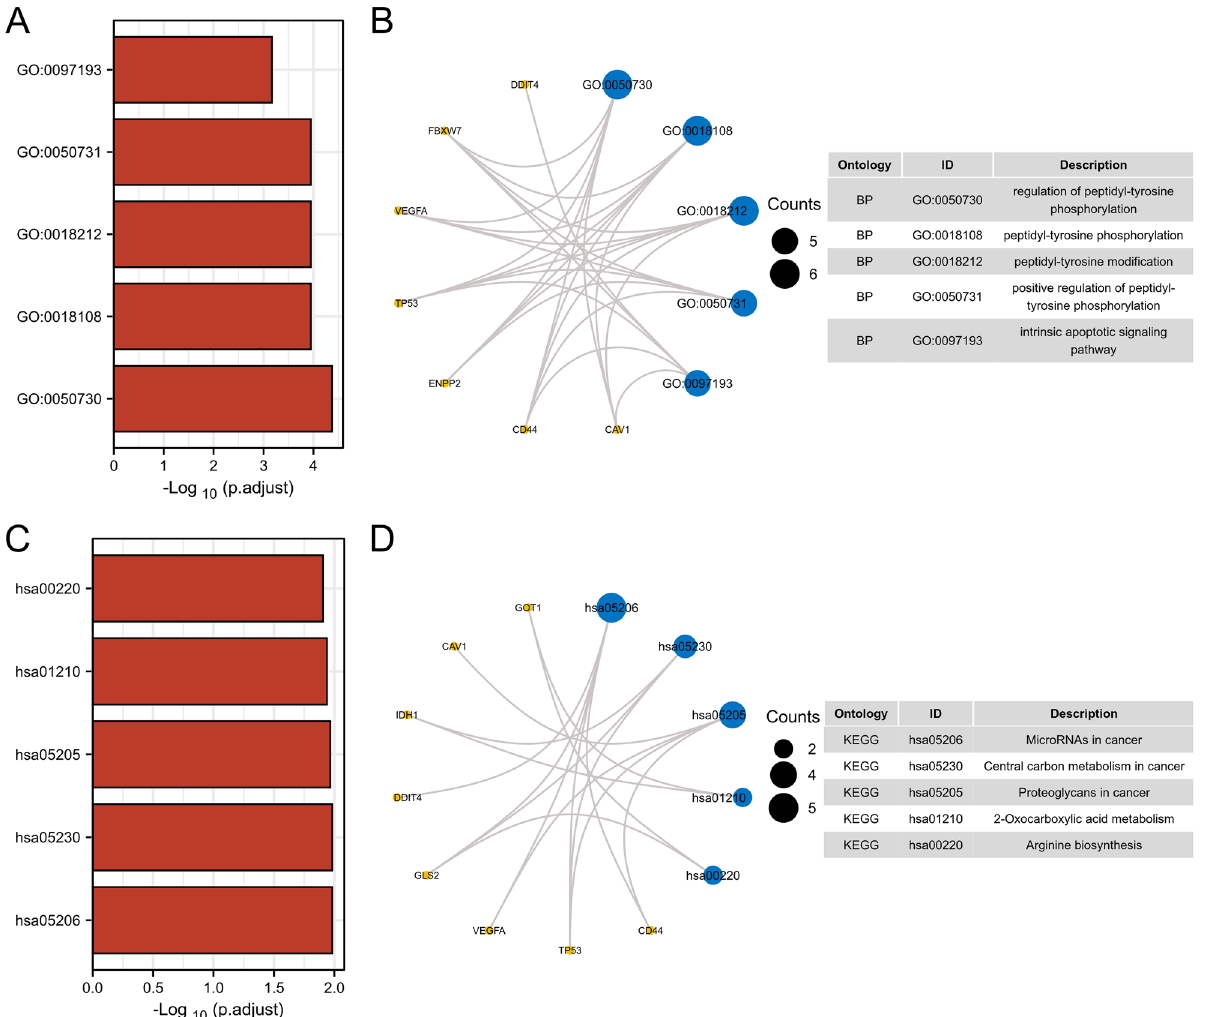
Figure 3. Enrichment analysis of ferroptosis-related genes. Using the top 5 significant enriched terms ( A ) to construct the GO visualization network ( B ). Using the top 5 significant enriched pathways ( C ) to construct the KEGG visualization network ( D